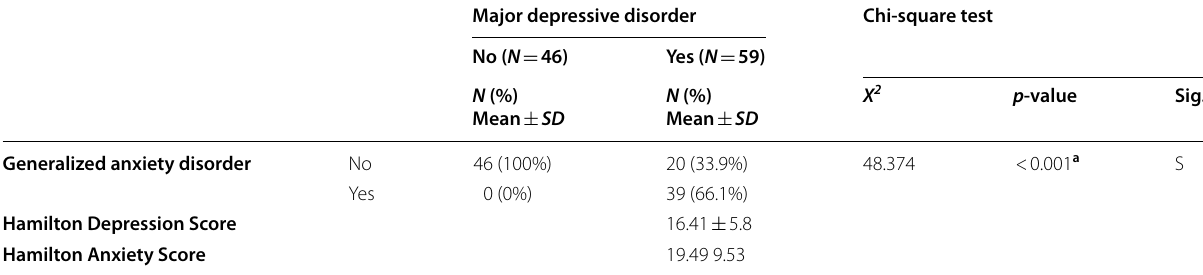
a Chi-square test of significance; X 2 , chi-square test value